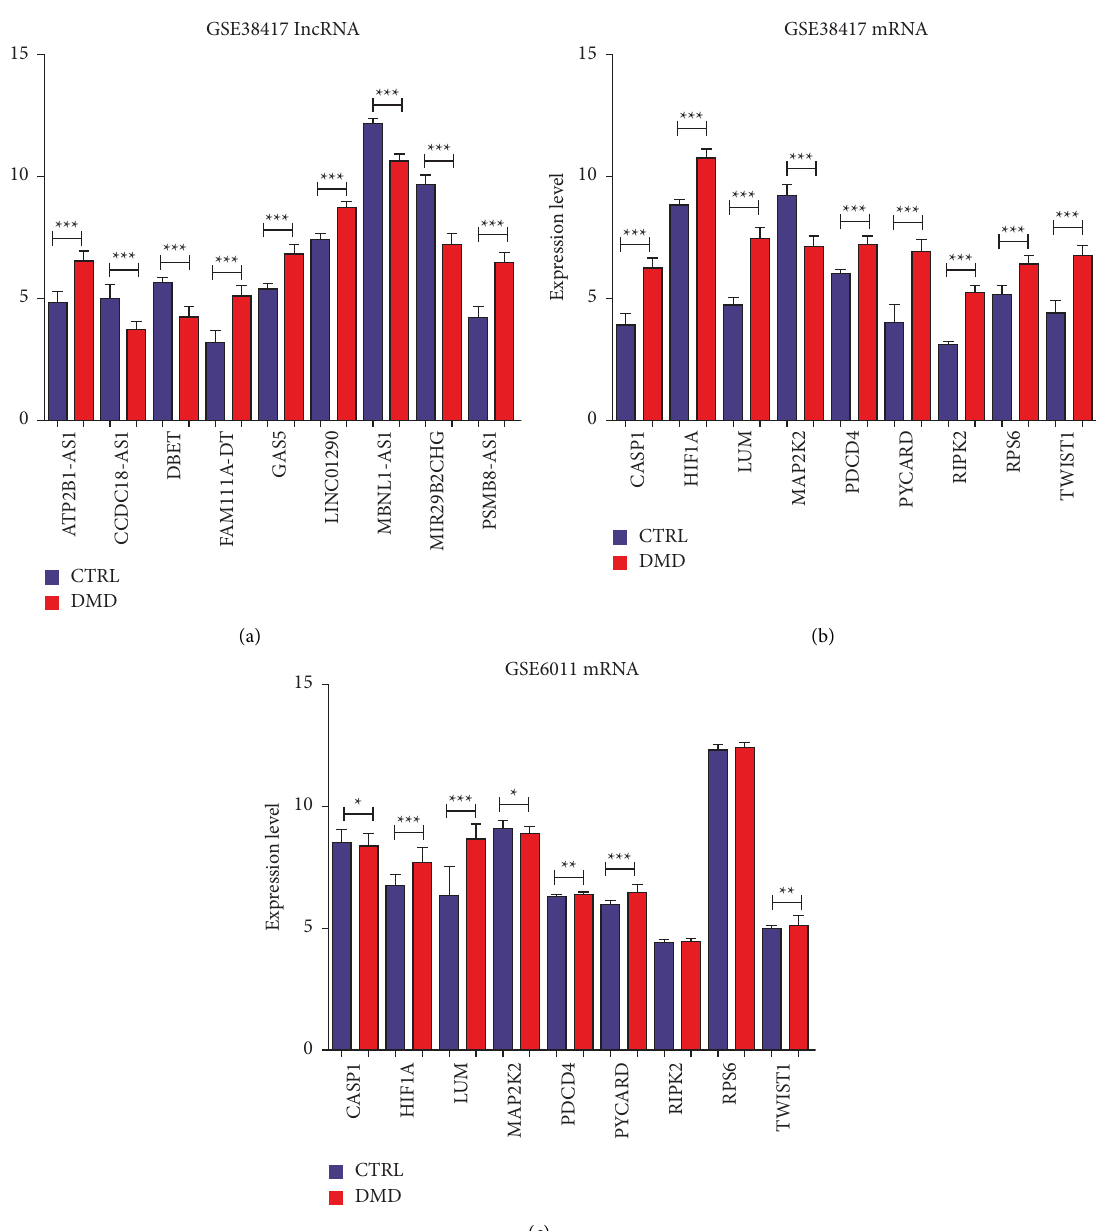
Figure 7: Validation of the crucial factors (lncRNAs and mRNAs) in the training (GSE38417) and validation (GSE6011) sets. (a) Expression of the nine DELs in the DMD-related lncRNA-mRNA pathway network between DMD and normal control samples in GSE38417. (b) Expression of the nine DMD-related DEMs between DMD and normal control samples in GSE38417. (c) Expression of the nine DMD- related DEMs between DMD and normal control samples in GSE6011. ∗ P < 0 . 05; ∗∗ P < 0 . 01; ∗∗∗ P < 0 .